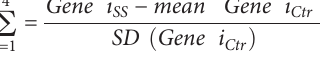
Control SS- subjects